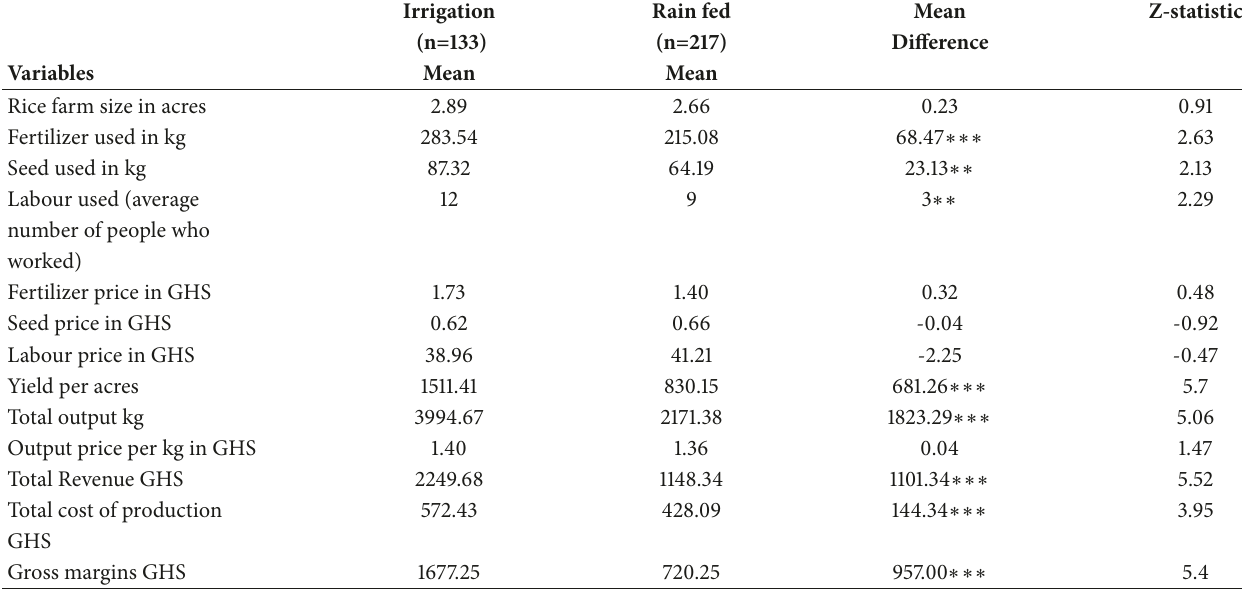
Table 4: Production situation under rain fed and irrigation production.